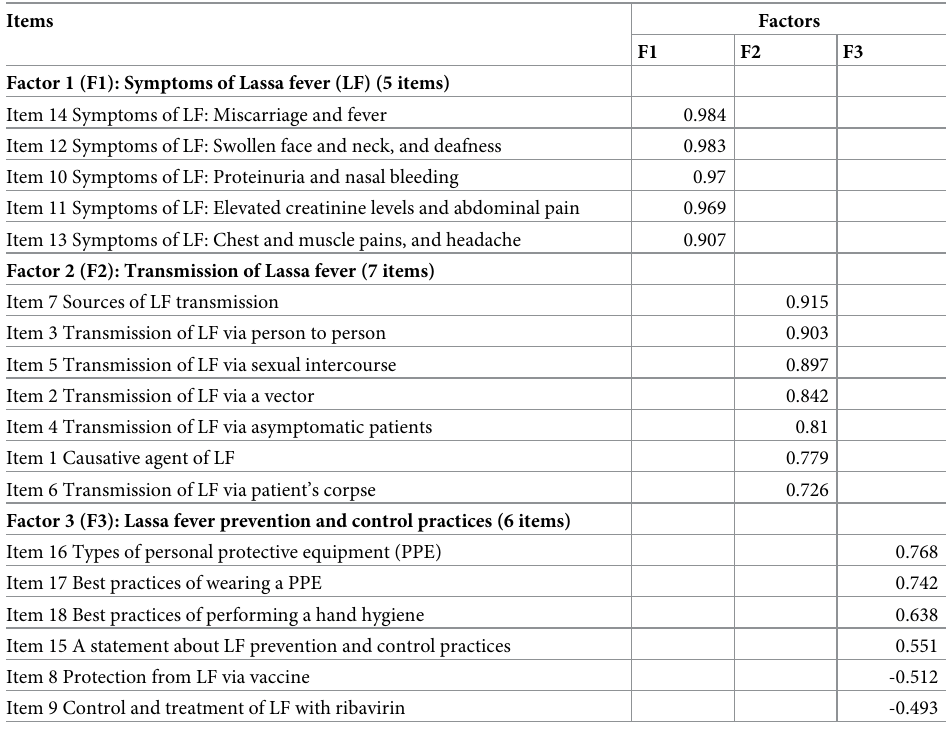
Table 3. Factor loading results after Oblimin